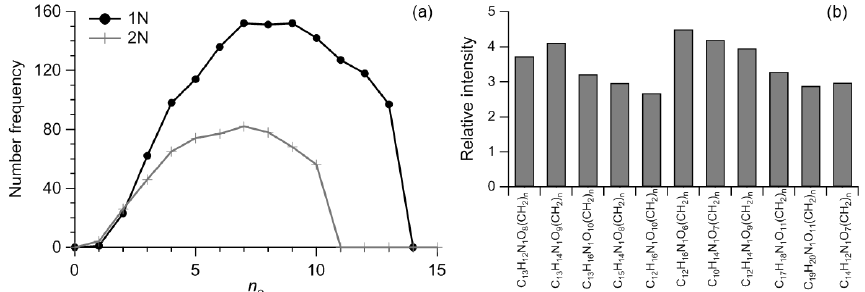
Figure 6. (a) The number frequency distribution of n o for 1N and 2N compounds and (b) the longest 10 CH 2 homologous series compounds in 1N